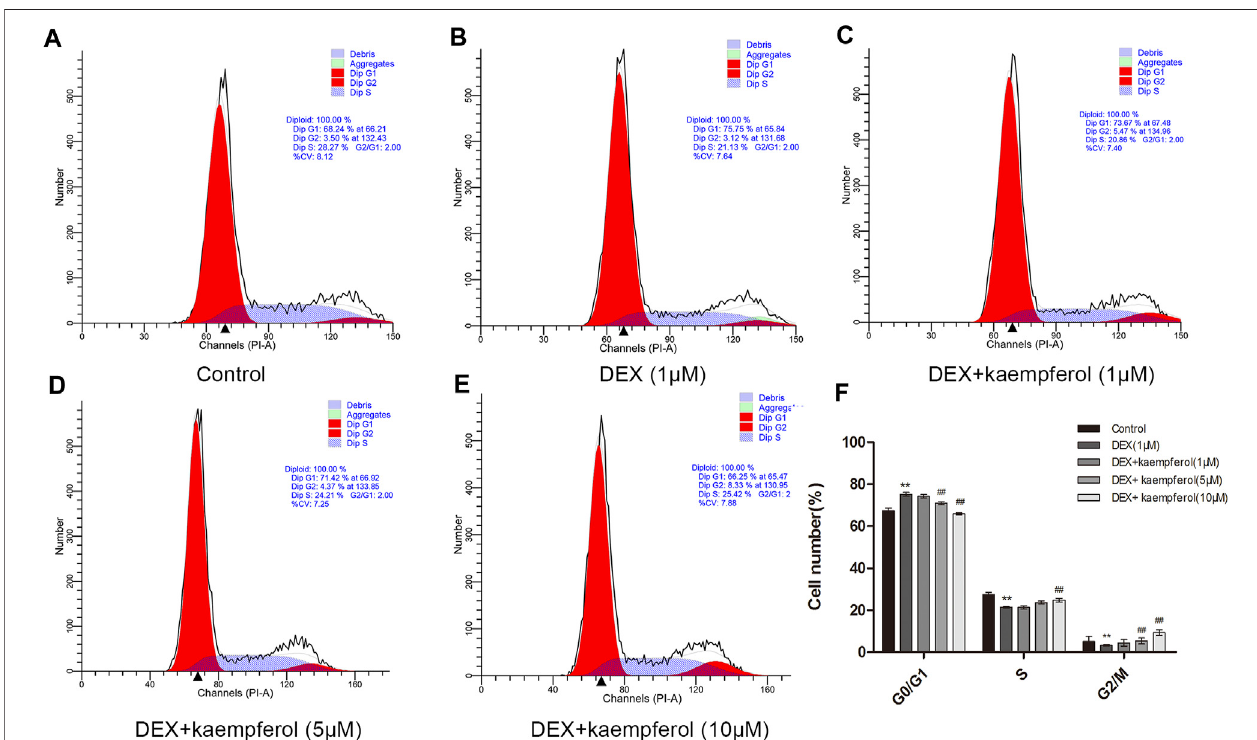
FIGURE2| KaempferolalleviatedcellcyclearrestinducedbyDEXinMC3T3-E1cells.Cellswereco-culturedwithkaempferol(1,5,and10 μ M)andDEX(1 μ M)for 3 days. A: Control; B: DEX (1 μ M); C: DEX + kaempferol (1 μ M); D: DEX + kaempferol (5 μ M); E: DEX + kaempferol (10 μ M); F: the bar graph of cell number (%) in cell cycles. ** p < 0.01 vs. Control; ## p < 0.01 vs.